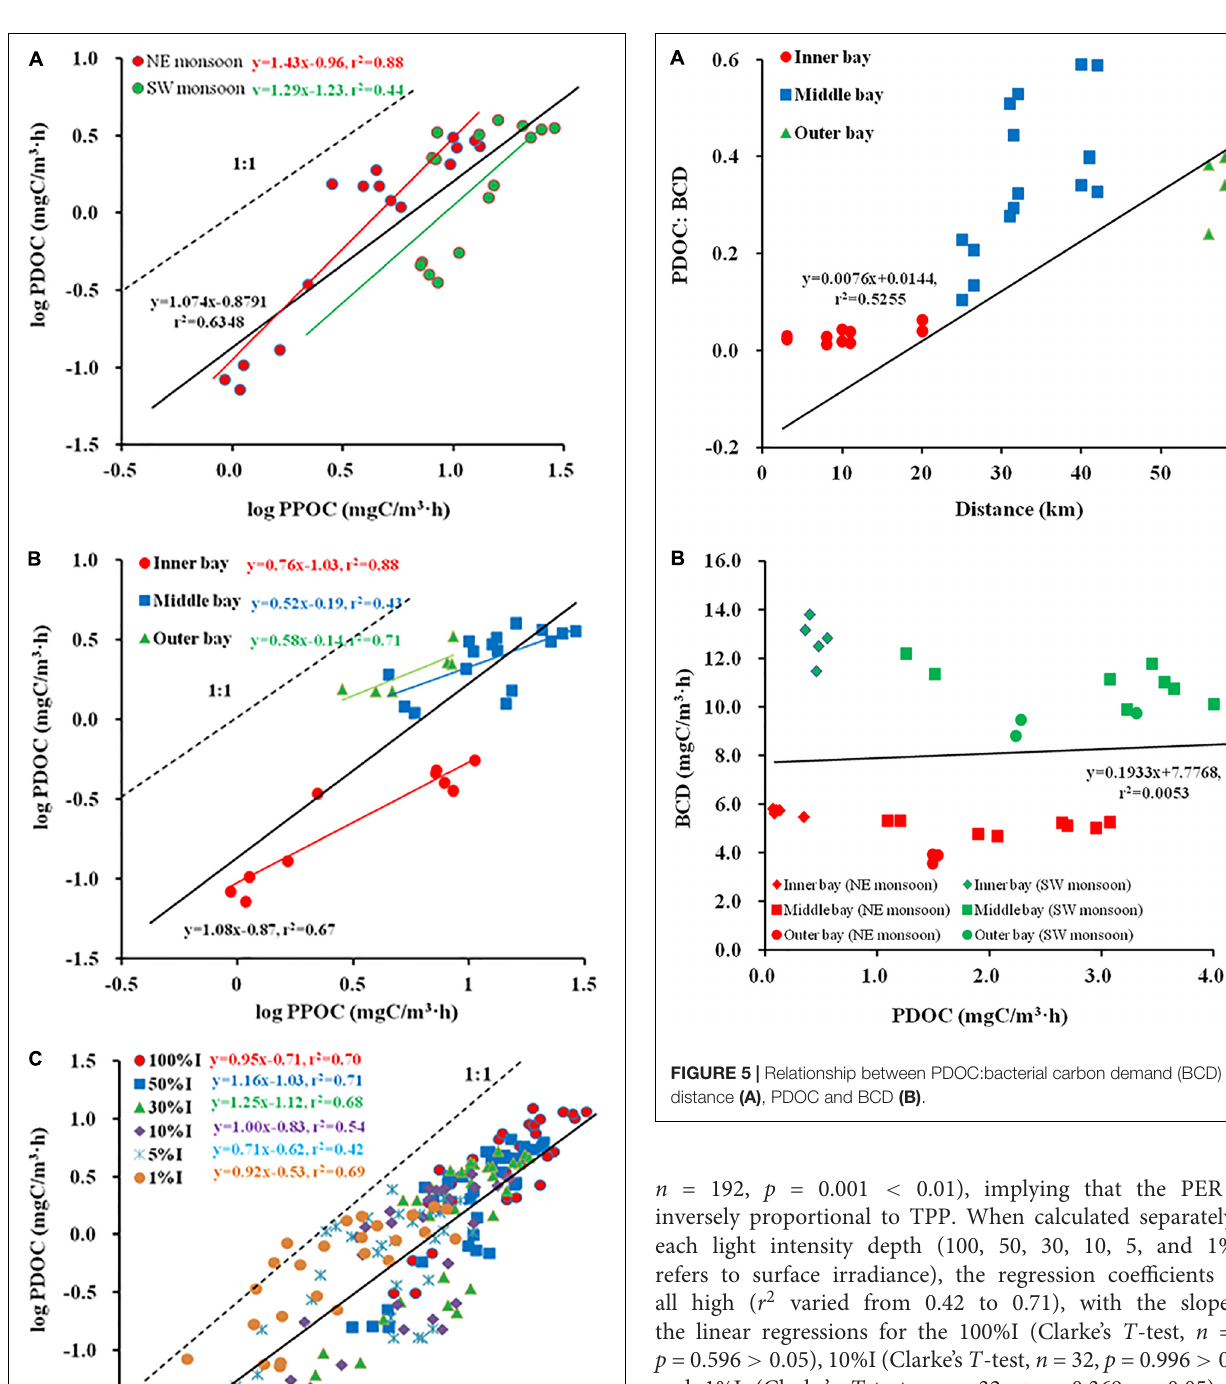
n = 192, p = 0.001 < 0.01), implying that the PER was inversely proportional to TPP. When calculated separately for each light intensity depth (100, 50, 30, 10, 5, and 1%I; I refers to surface irradiance), the regression coefficients were all high ( r 2 varied from 0.42 to 0.71), with the slopes of the linear regressions for the 100%I (Clarke’s T -test, n = 32, p = 0.596 > 0.05), 10%I (Clarke’s T -test, n = 32, p = 0.996 > 0.05), and 1%I (Clarke’s T -test, n = 32, p = 0.369 > 0.05) light intensity depths not significantly different from 1 (0.95, 1, and 0.92), indicating that the PER is relatively constant across the whole range of measured POC production. While at other light intensity depths, i.e., 50%I (Clarke’s T -test, n = 32, p = 0 < 0.01), 30%I (Clarke’s T -test, n = 32, p = 0.042 < 0.05), 5%I (Clarke’s T -test, n = 32, p = 0.023 < 0.05), the slope of linear regression was significantly different from 1 (1.16, 1.25, and 0.71), implying that PER tends to rise or fall with increased